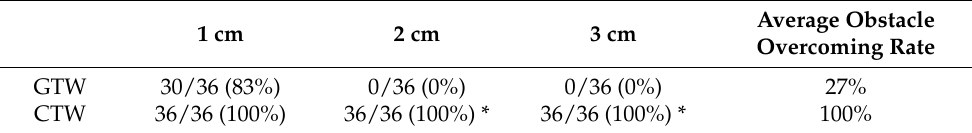
Table 7. The number of overcome obstacles in obstacle